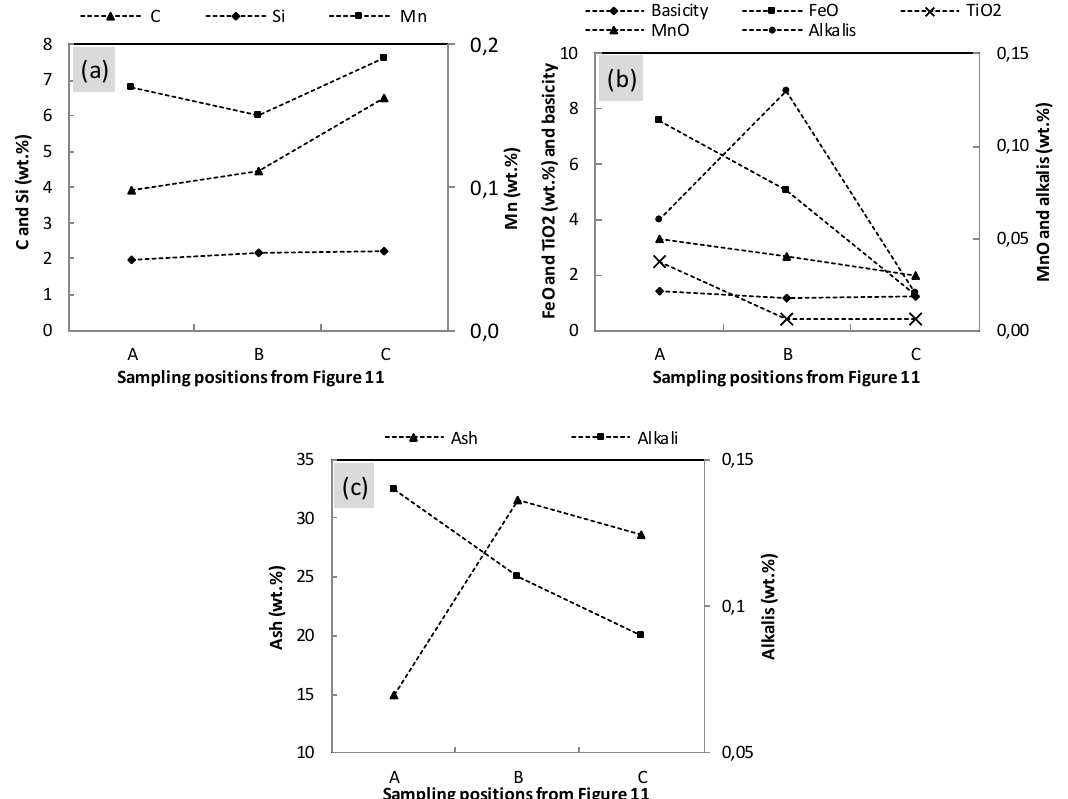
Figure 12. Variations of the selected elements from ( a ) metal samples; ( b ) slag samples; and ( c ) coke samples along the flow field from A to C in Figure 11.